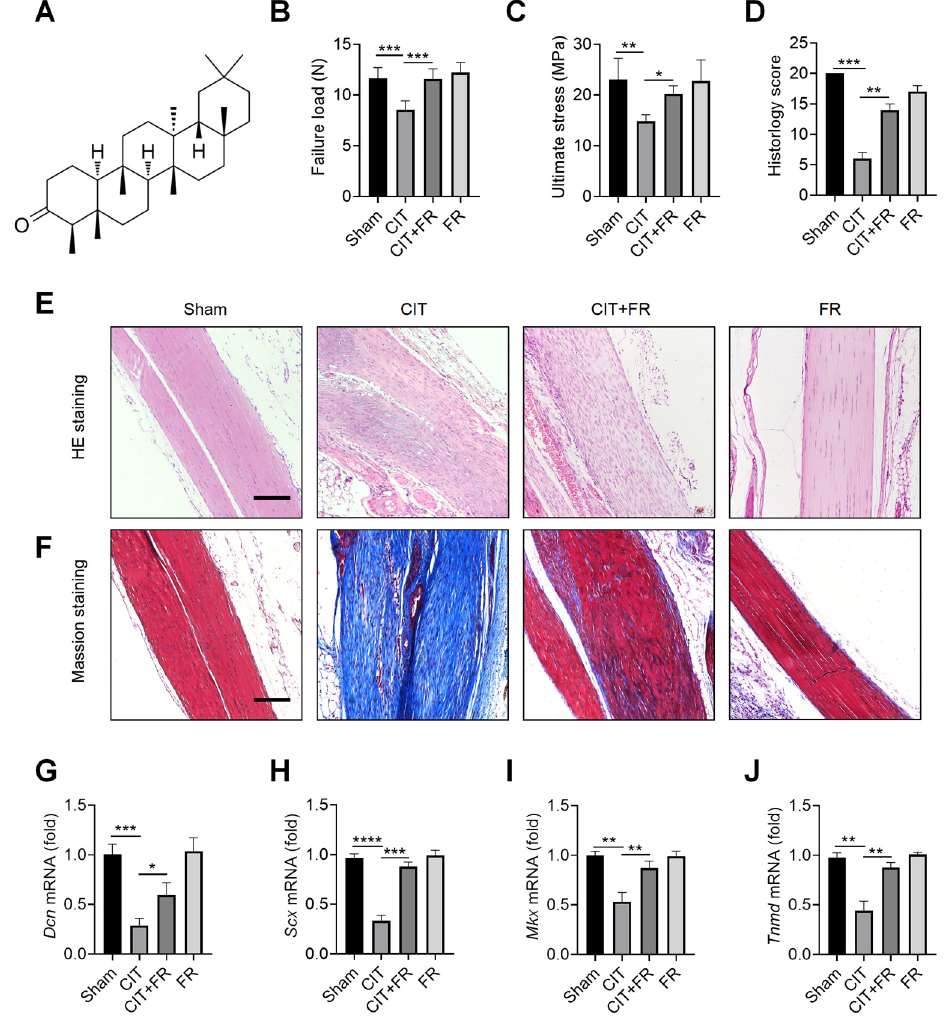
Figure 1. Progression of tendinopathy is alleviated by FR in mice. ( A ) The chemical structural formula of FR. Four weeks after treatment in mice, the Achilles tendons were collected for experimental detection. Biomechanical detection of the effect of FR on Achilles tendon healing: failure load ( B ), ultimate stress ( C ). ( D ) Histological score of HE staining. ( E ) HE staining was used to detect the effect of FR on the histological healing of the Achilles tendon in mice. ( F ) Masson’s staining was used to detect the effect of FR on the formation of collagen fibers in the process of tendinopathy in mice. ( G – J ) The effect of FR on the expression of tendon-forming factors ( Dcn , Scx , Mkx , and Tnmd ) was detected by qRT-PCR. Scale bar: 100 μ m. Data are expressed as the means ± SD from three independent experiments. * p < 0.05, ** p < 0.01, *** p < 0.001, **** p < 0.0001